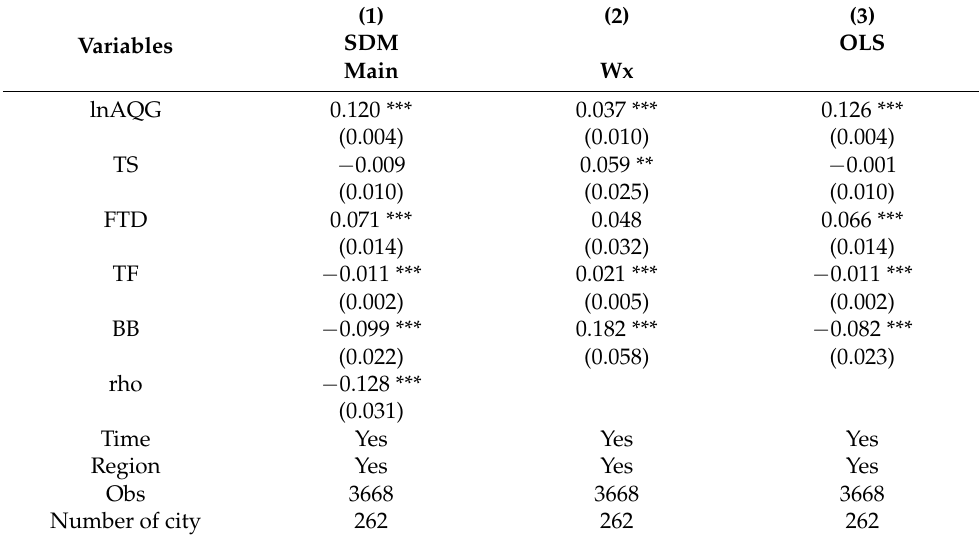
Table 3. Spatial Durbin model (SDM) regression estimation results.